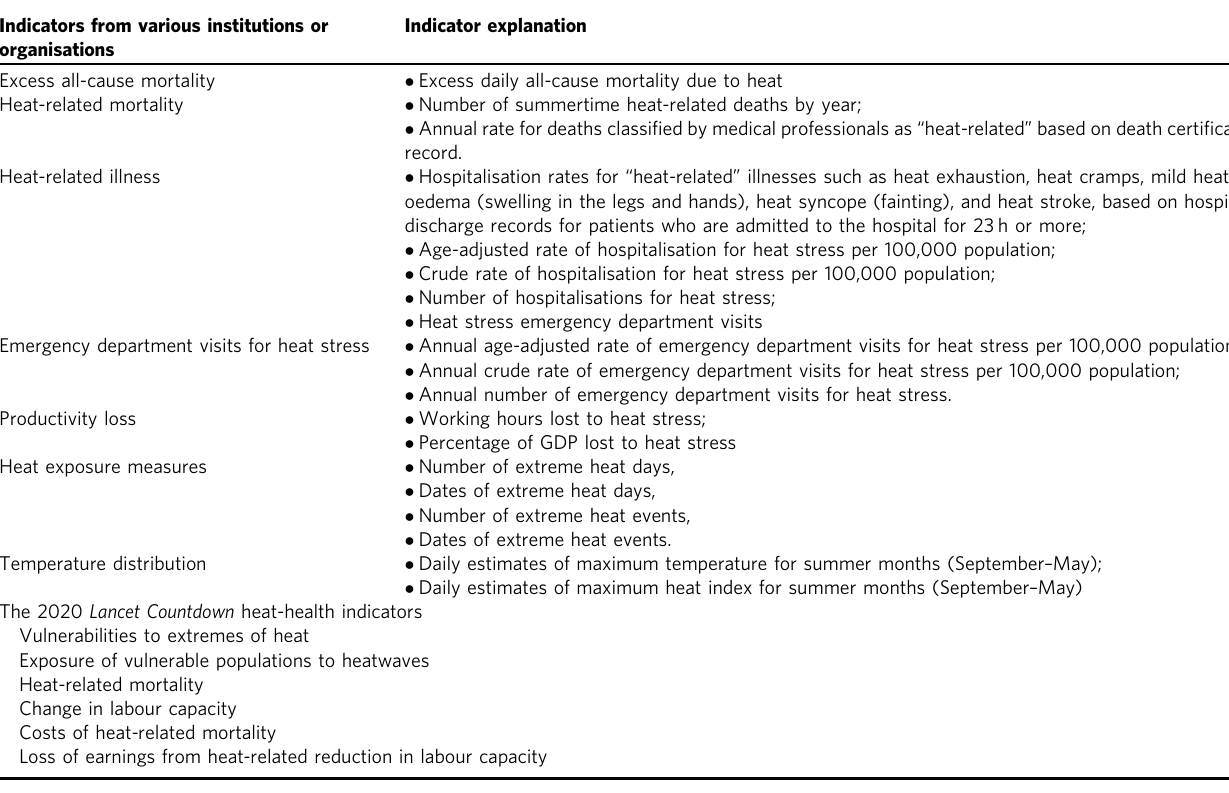
Table 2 Summary of available/applied human-related heat-health indicators.